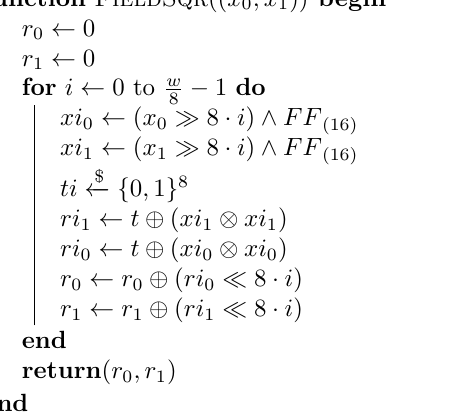
squaring operation (under Boolean 2 8